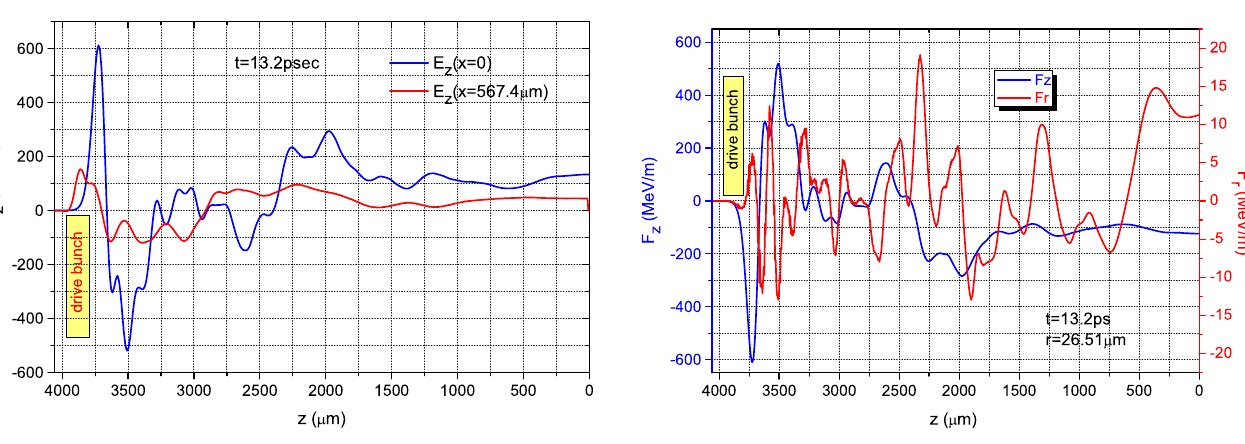
FIG. 18. (Color) Axial (blue line) and transverse (red line) forces acting upon electron versus z , at r ¼ 26 : 51 (cid:1) m from the central axis in a witness bunch channel. The witness bunch would be placed at z ¼ 3500 (cid:1) m